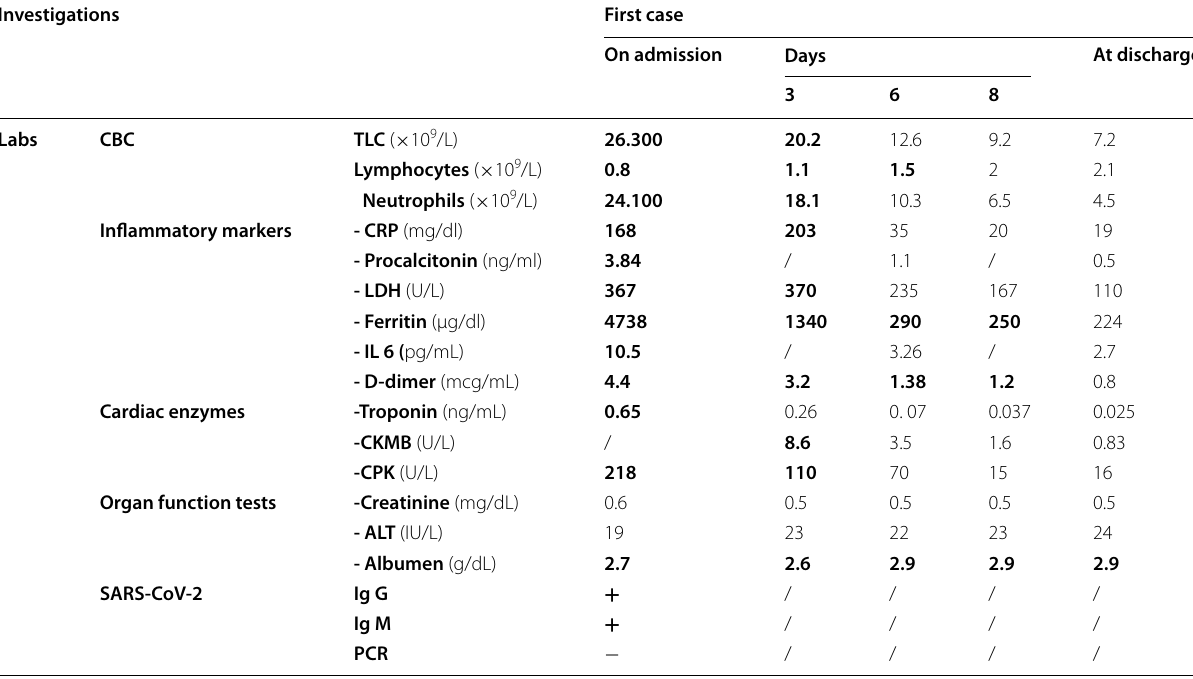
NB: Bold means significant values in diagnosis (see text). Daily laboratory evaluation was performed. Only data of significant changes was mentioned